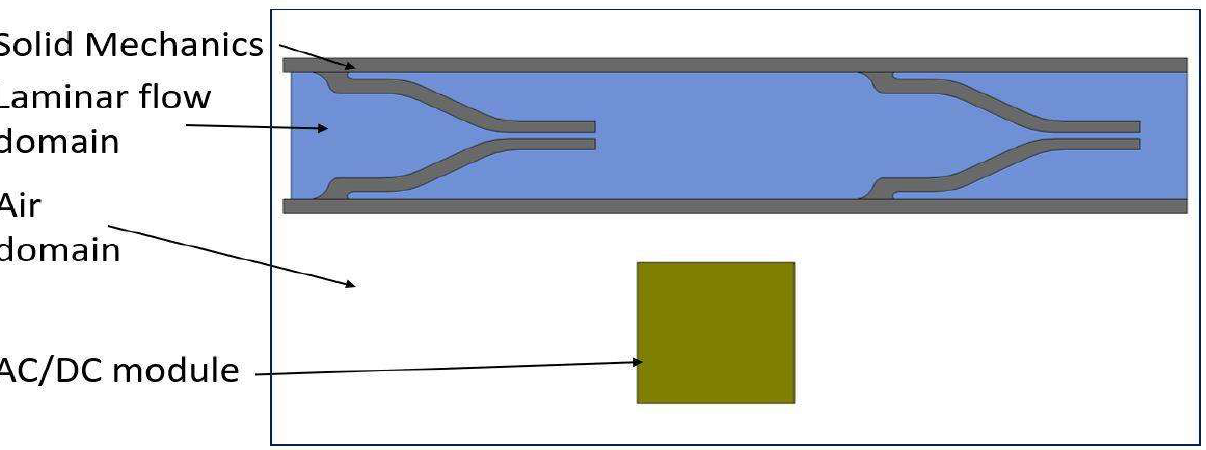
Figure 4. 2D simulation model geometry.